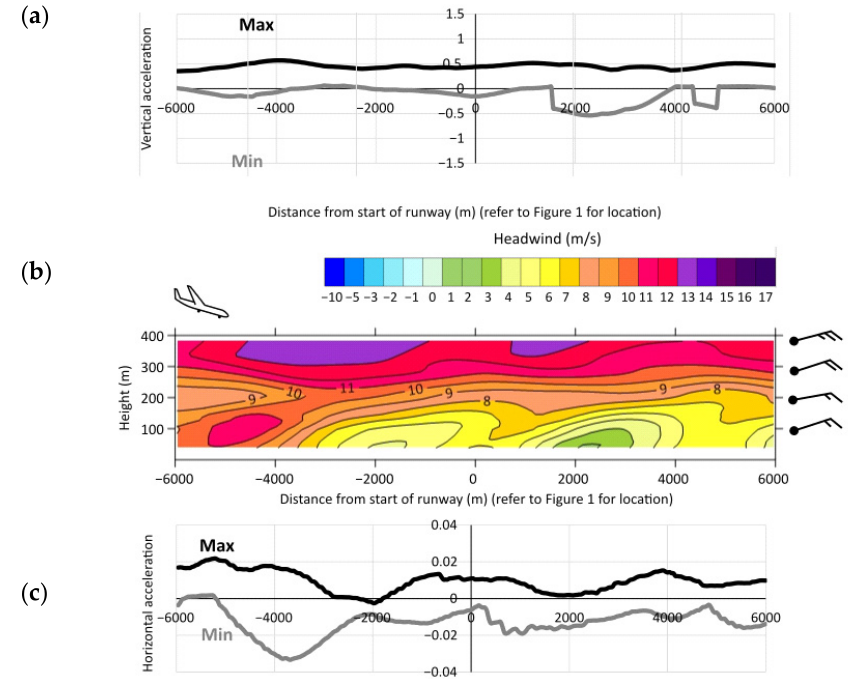
Figure 6. Derivation of metrics for a wind event occurring on 7 January 2018 coinciding with 07LA (event time 09:25, local time zone, modelled time 09:05, local time zone): ( a ) modelled minimum and maximum vertical acceleration, ( b ) modelled headwind on vertical slice, ( c ) modelled minimum and maximum horizontal acceleration. Selected wind observations at CCH (every 100 m) are displayed as wind barbs (in knots) to the right of the headwind vertical slice.